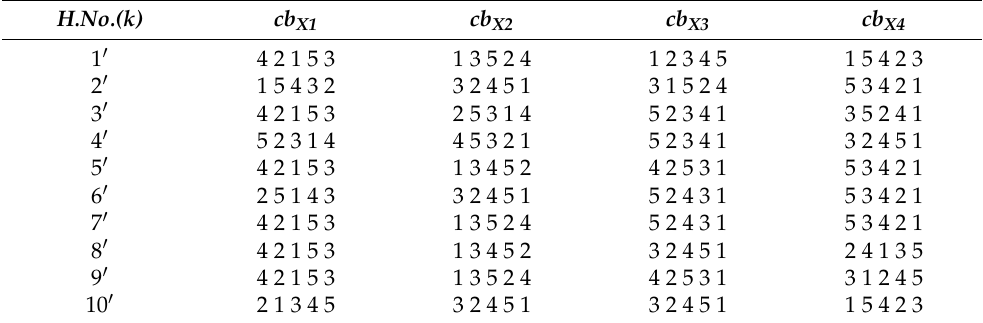
Table 10. Harmony after